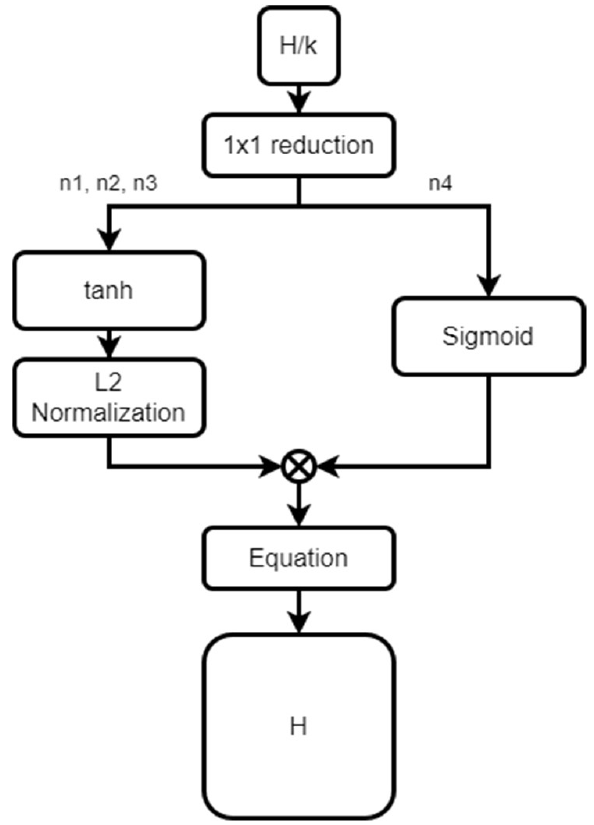
Figure 2. Local planar guidance.